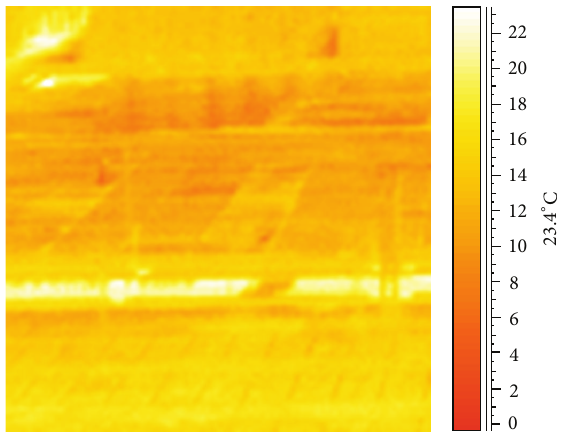
Figure 9: The eigenpoint distribution obtained from Figure 7 using the proposed method.